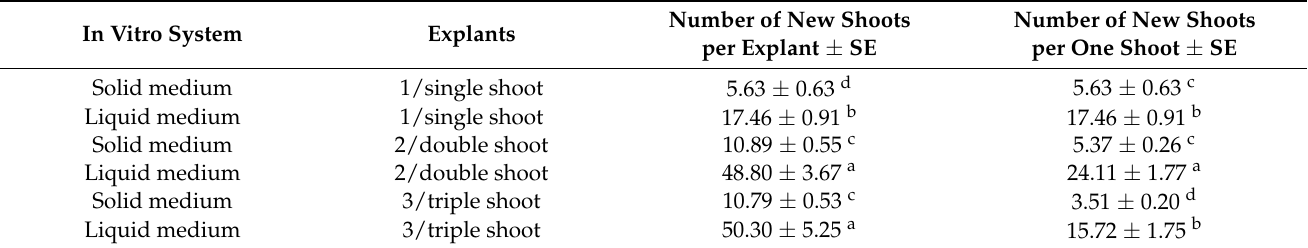
Table 4. The comparative statement on Linnaea borealis var. borealis shoot multiplication in different systems with